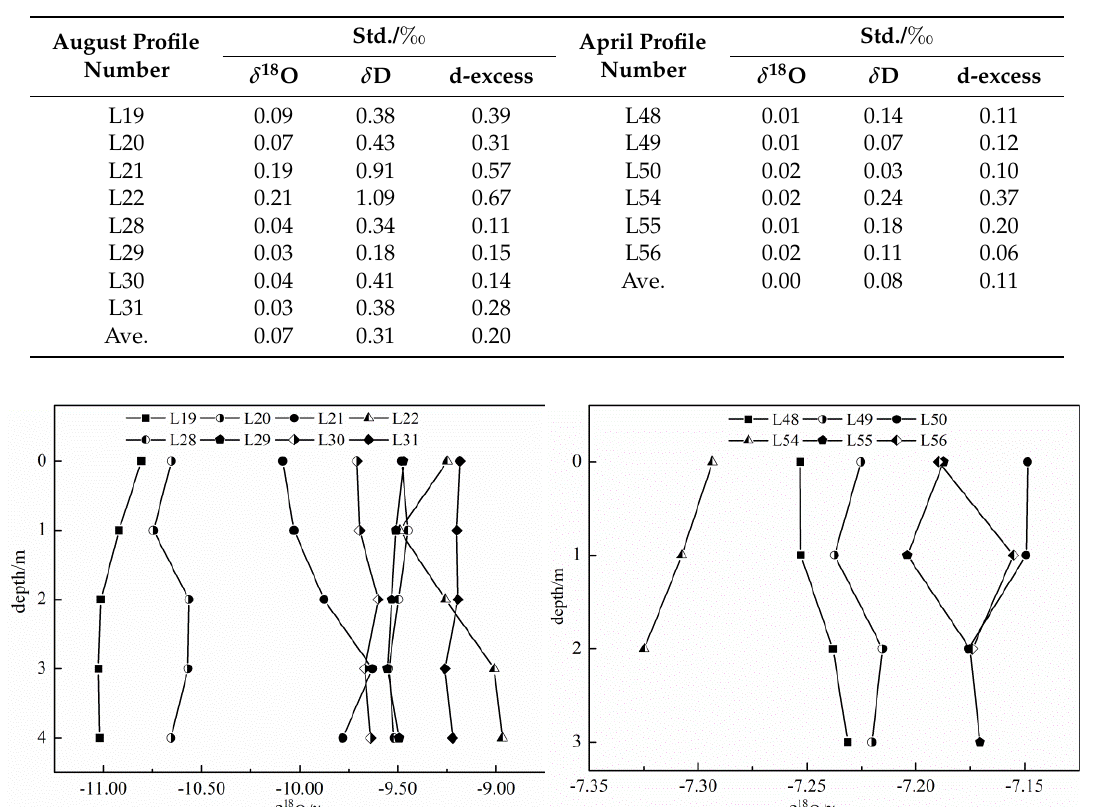
Table 2. The standard deviation of all profiles water isotope.